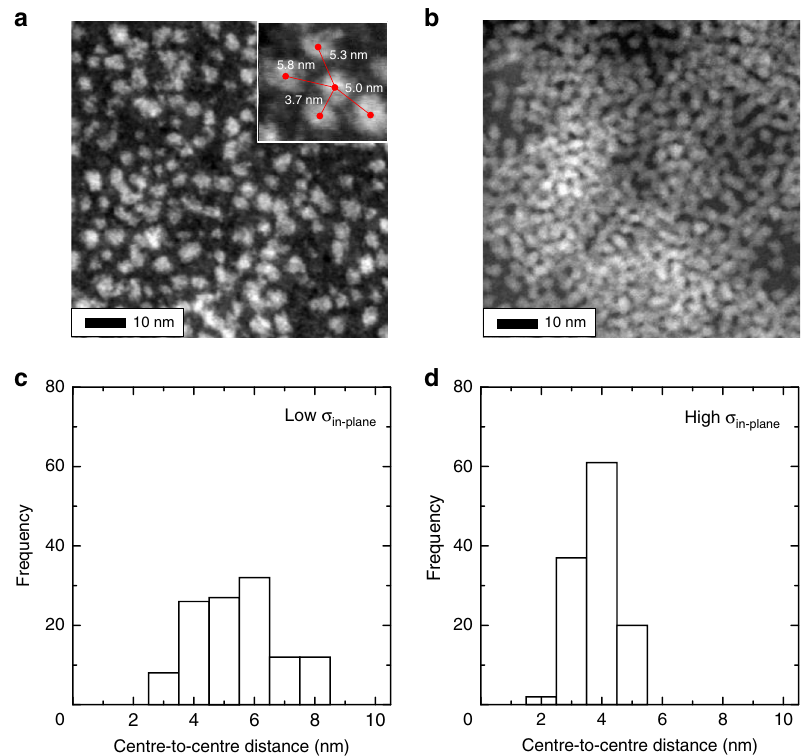
Fig. 3 Scanning transmission electron microscopy images of quantum dot monolayers. a , b Scanning transmission electron microscopy images of quantum dot monolayers with low a and high b in-plane quantum dot density ( σ in-plane ), which were fabricated with OD sol = 0.02 and 0.15, respectively. The inset in the fi gure is the enlarged image. The red dots point to the centre of the quantum dots, and the red lines connect the points. The numbers shown in white indicate the length of the red lines, which are centre-to-centre distance between quantum dots. c , d Histograms of the centre-to-centre distances between quantum dots in the quantum dot monolayers with low c and high d σ in-plane